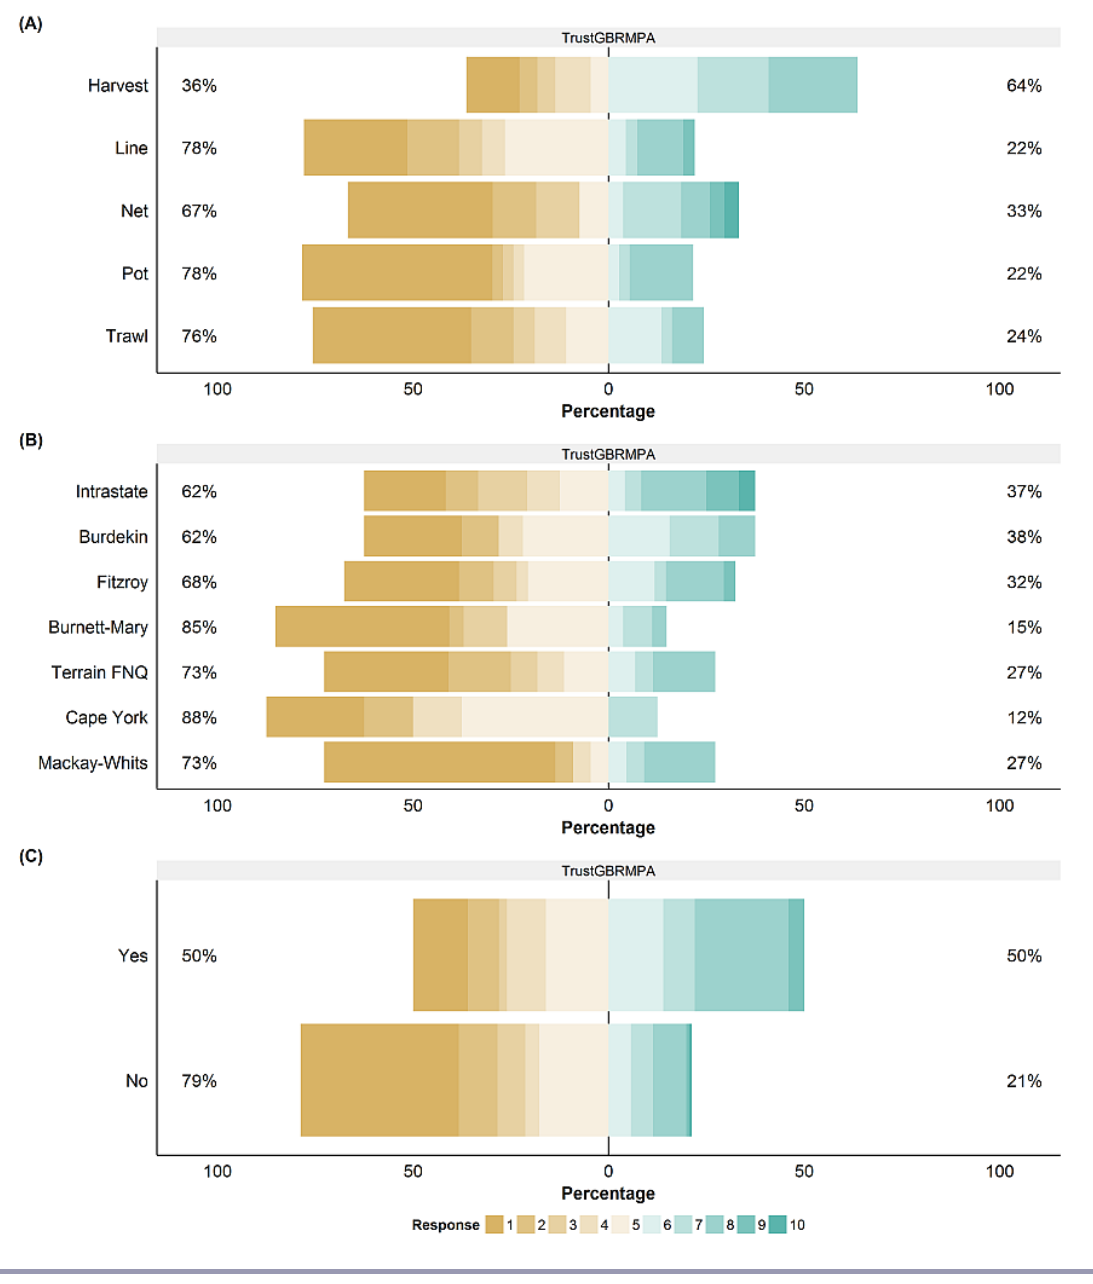
Fig. 3. Perceptions of trust in information from the Great Barrier Marine Park Authority (GBRMPA) among commercial fishers in relation to characteristics of respondents. (A) Main gear type. (B) Participation in the Reef Guardian program. (C) Home port natural resource management area. Shading represents the proportion of respondents choosing each score on a 10-point ordinal scale (1 = very strongly disagree, 10 = very strongly agree). GBR = Great Barrier